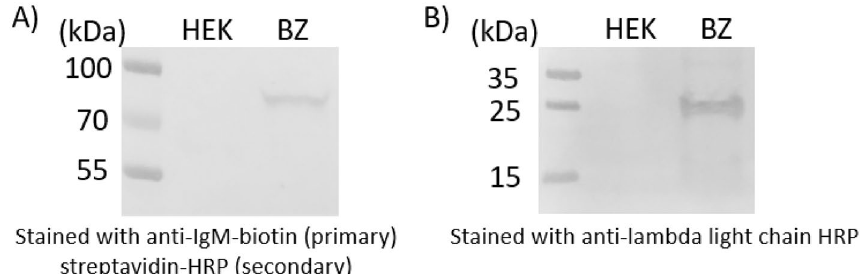
Figure 2. Immunoblotting of the engineered BZ and HEK background cell lysates separated by SDS-PAGE. ( A ) Heavy chain anti-IgM staining and ( B ) light chain anti-lambda staining of the cell lysates from the engineered BZ cell line and the HEK background from which BZ was derived reveal expression of IgM heavy chain and lambda light chain for the BZ cell line but not observed for the HEK background. The light chain band appears at ~ 25 kDa which is the expected size for the unglycoyslated light chain, while the heavy chain appears larger than the unglycosylated molecular weight of ~ 66 kDa indicating that the heavy chain has indeed been glycosylated.